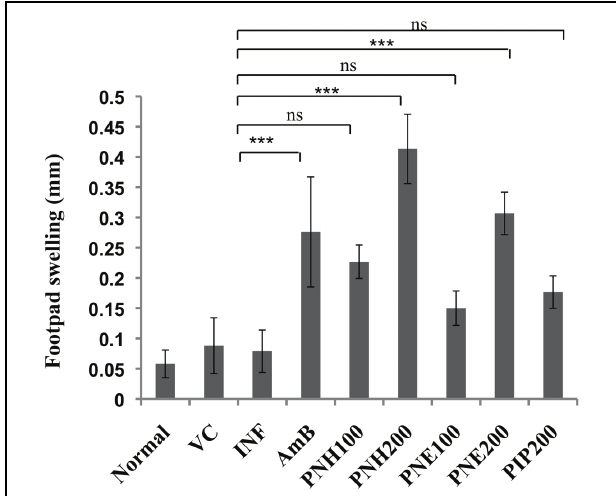
FIGURE 5 | Evaluation of DTH response. After two weeks of treatment, animals were either inoculated with FT or PBS alone in hind footpads and DTH was measured post 24 h as described in methodology section. ∗∗∗ P < 0.001 and ns = non-significant in comparison to INF.